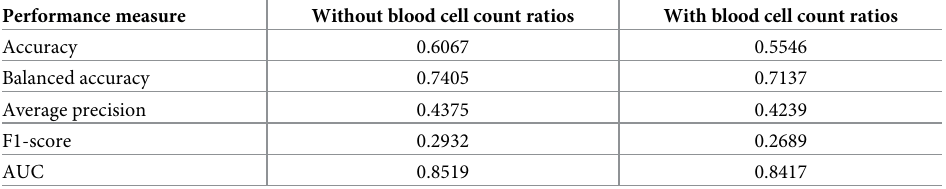
The model included the features: age group, sex and laboratory blood test results of ten CBC parameters, with model optimization focusing on the prediction of secondary headaches. The model was evaluated using a single 80:20 train/ test dataset split. AUC, area under the receiver operator characteristic curve; CBC, complete blood